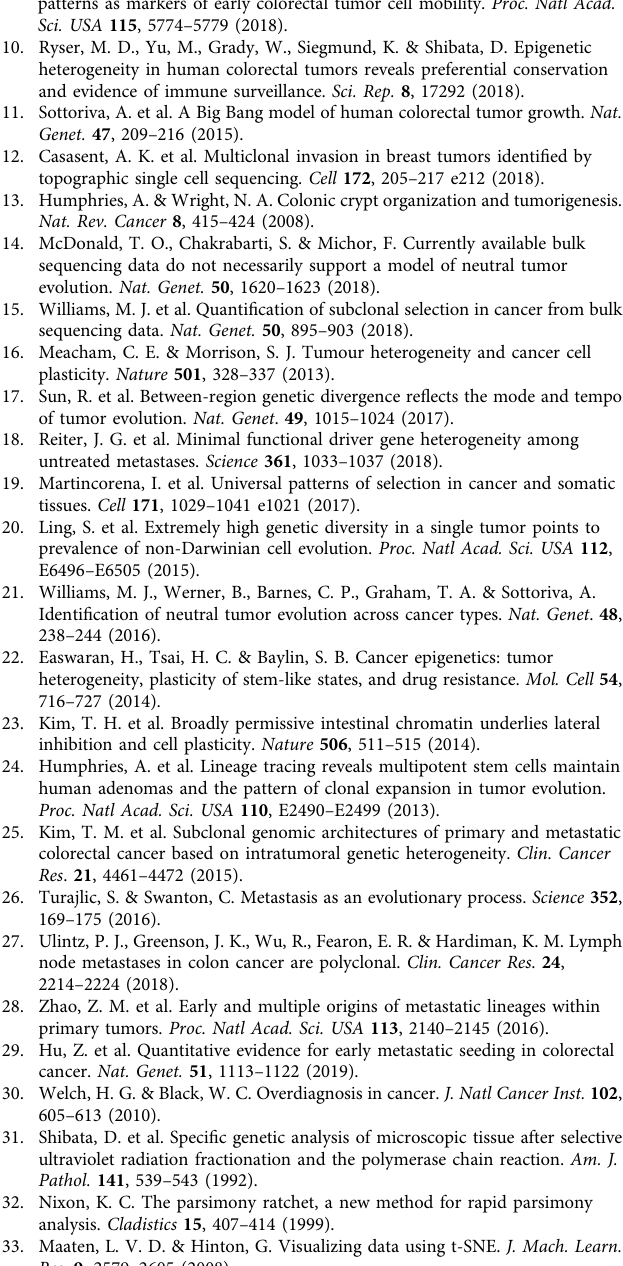
Table 1 for details on homoplasy